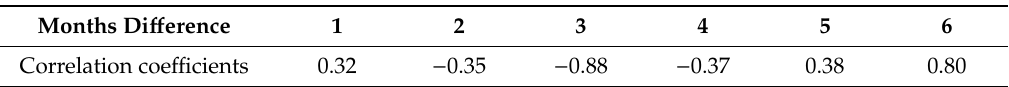
Table 4. Correlation coefficients between maximum loads.